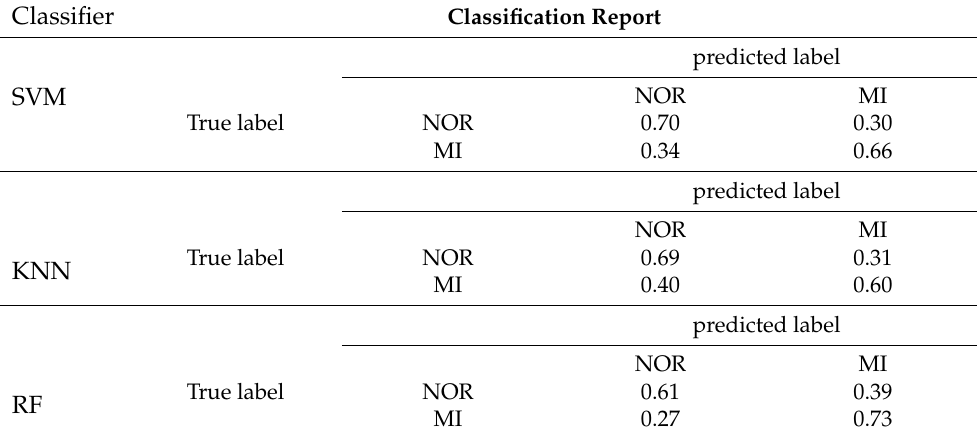
Table 7. Classification report.